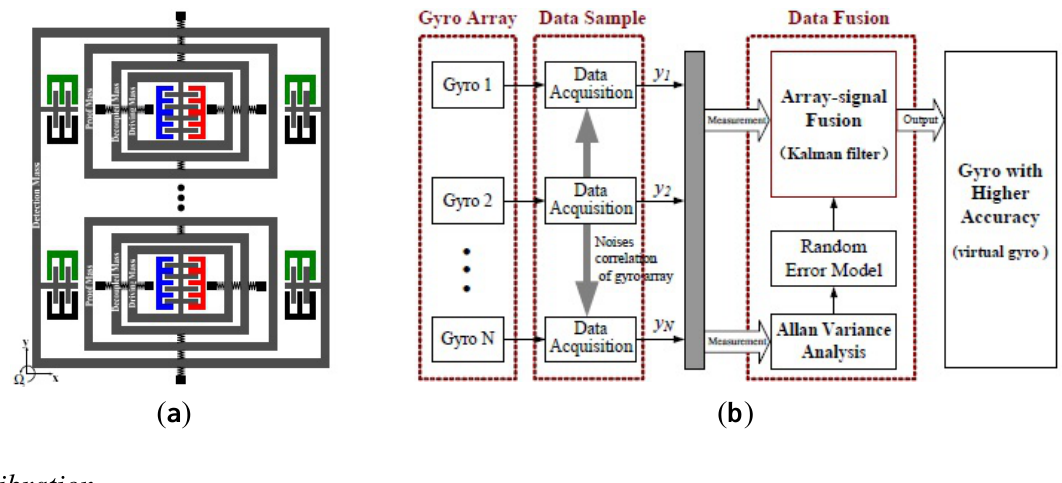
Figure 42. Gyroscope array. ( a ) Schematic of gyroscope array. ( b ) Digital process of gyroscope